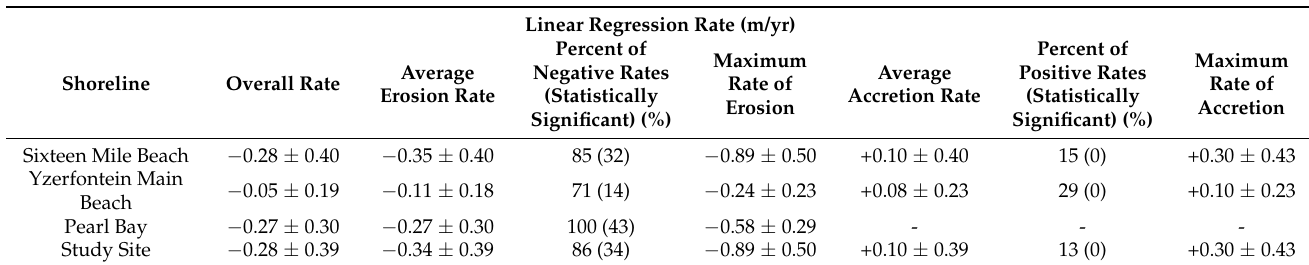
Table 8. Summary of Linear Regression Rate of change (LRR) to the study site shoreline and its three beaches with erosional rates as negative and accretional rates as positive. Linear Regression Rate (m/yr)